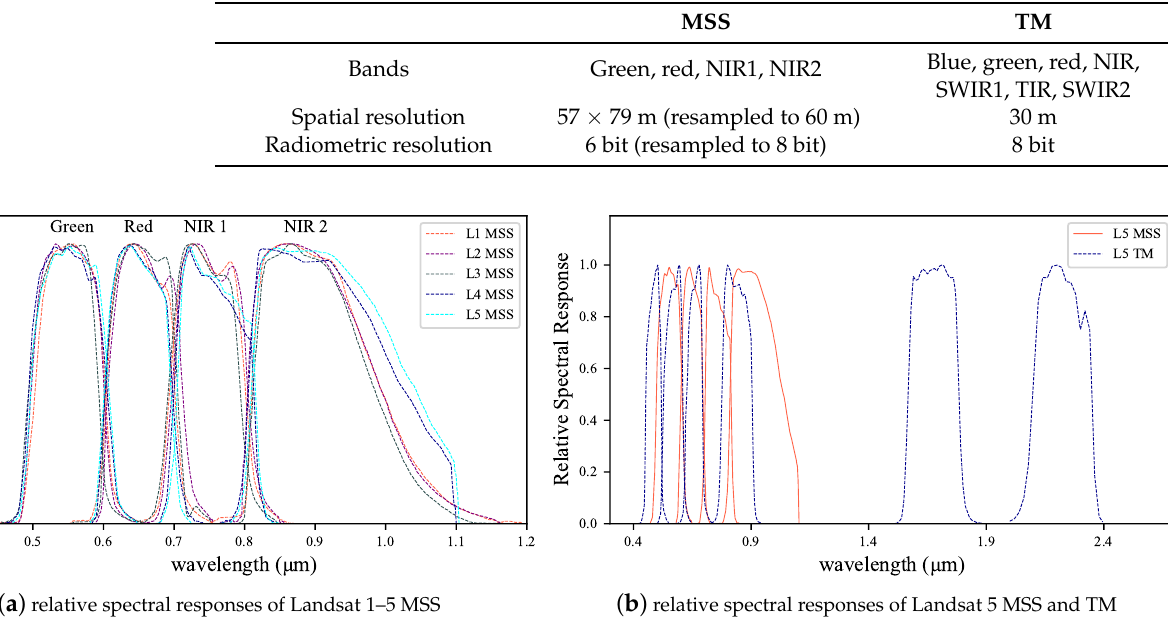
Table 1. The difference between MSS and TM images of Landsat Collection 1 Archive.